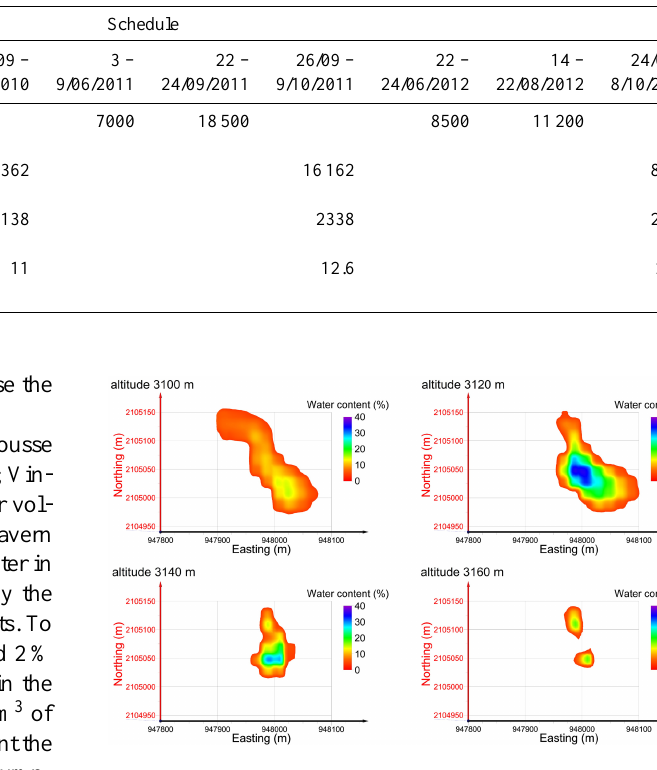
Fig. 8. 3-D-SNMR image of the water-filled cavern observed in September 2009 and shown as slices at different